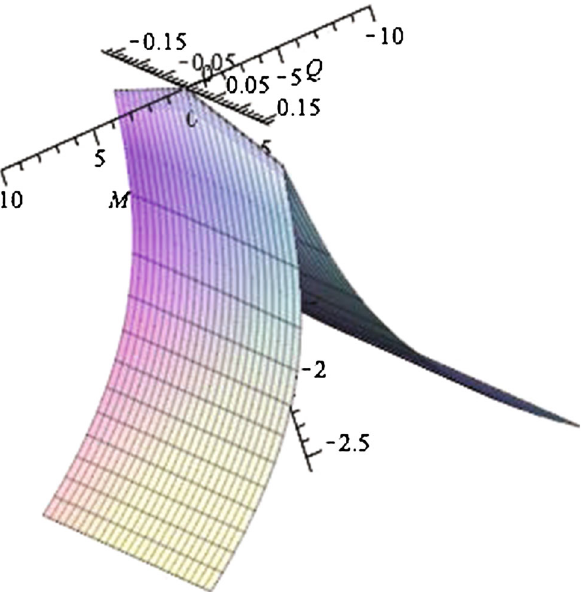
Fig. 8 Location of the roots ξ 1 for the RN black hole as a function of Q , M